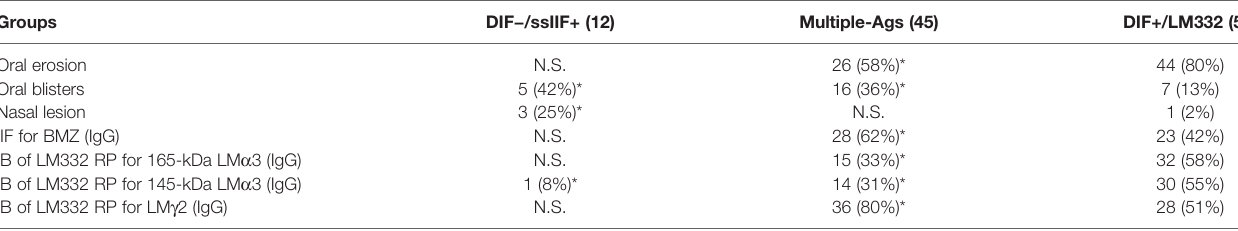
TABLE 4 | Comparisons of DIF − /ssIIF+ and multiple-Ags groups with DIF+/LM332 group. Groups Oral